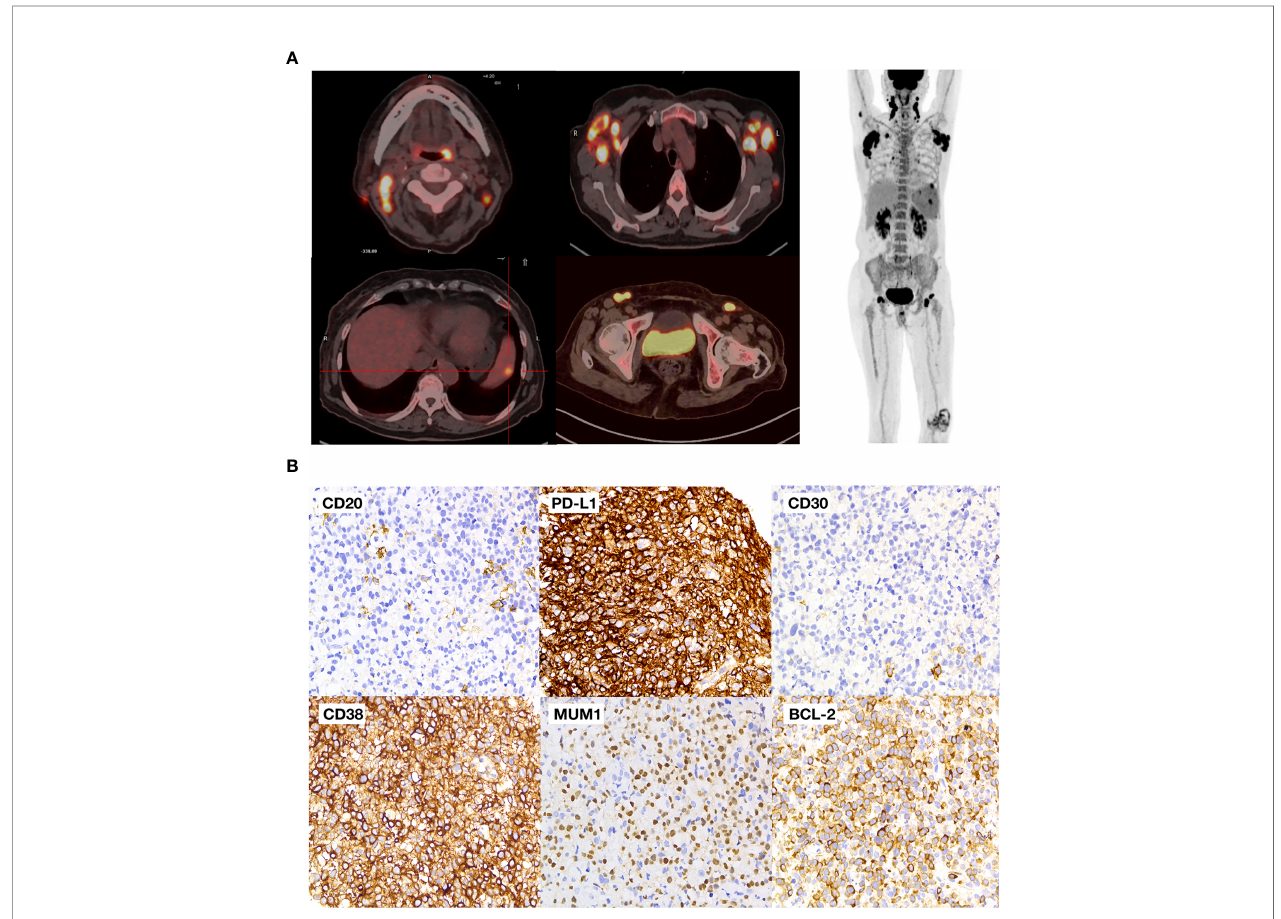
FIGURE 1 | Baseline PET-CT and pathological images (A) PET – CT images of the patient; (B) pathological images of the